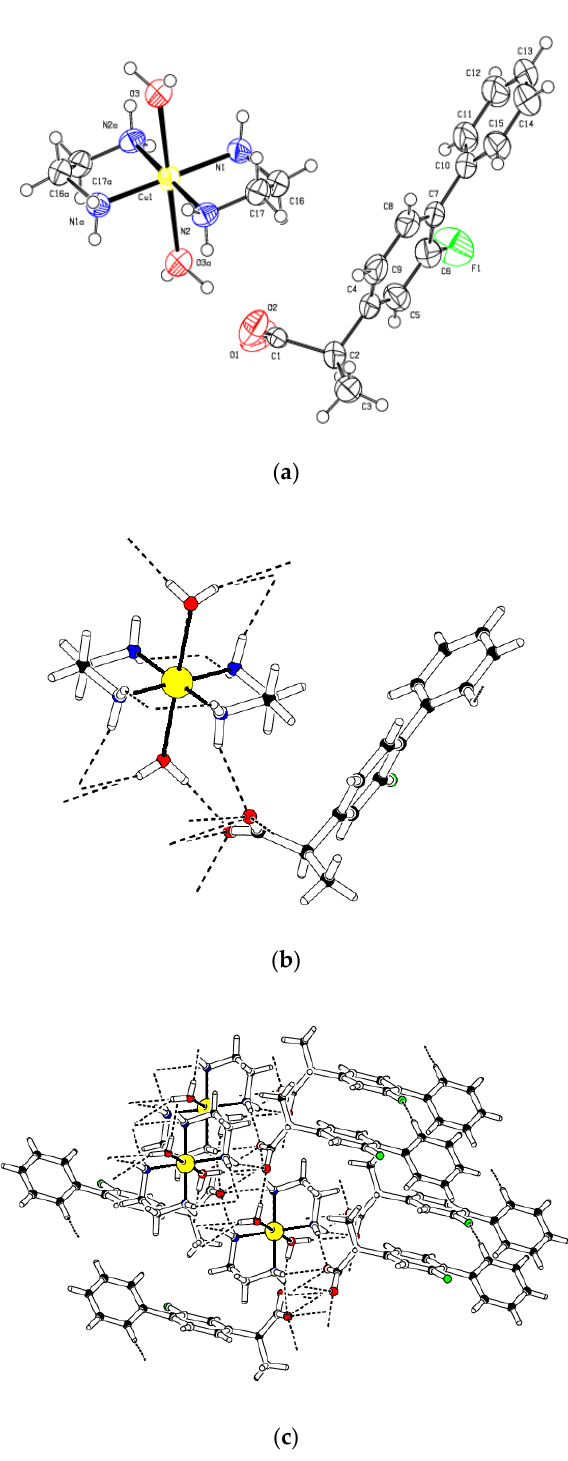
Figure 2. ORTEP diagram of 2b with thermal ellipsoids drawn at 50% probability level. The H- atoms are shown as small circles of arbitrary radii. Symmetry code i = 1 − x, − y, 1 − z ( a , b ). The two-dimensional polymeric network due to various H-bonding of 2b ( c ) (CCDC#